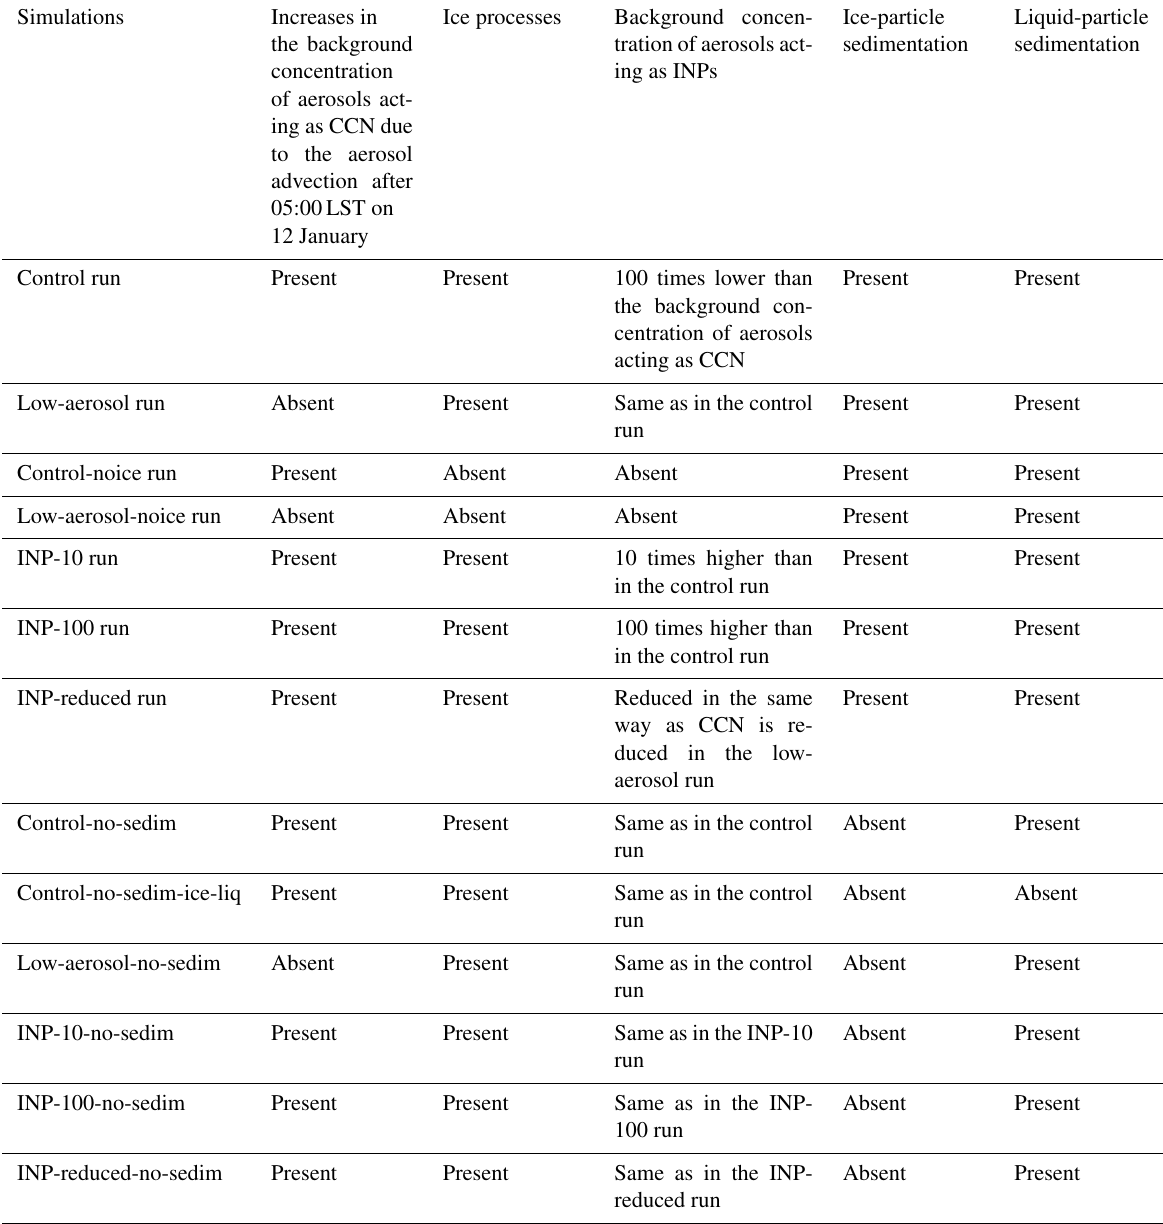
Table 1. Summary of